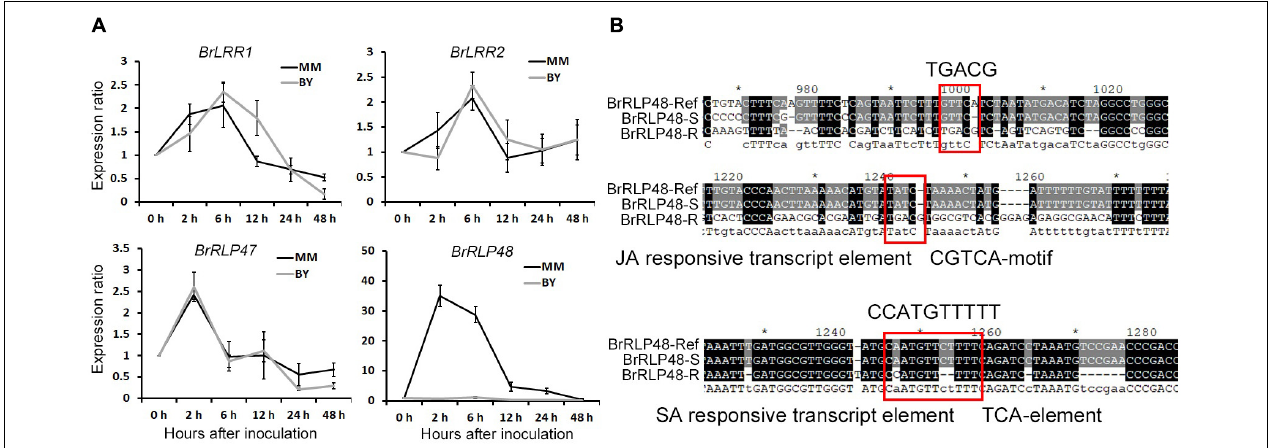
FIGURE 4 | Expression analysis of resistance candidate genes after inoculation and promoter analysis of BrRLP48 between BY and MM. (A) Expression analysis of BrLRR1 , BrLRR2 , BrRLP47 , and BrRLP48 after inoculation. Thirty seedlings of BY and MM were used. Ten to fifteen leaves were mixed in a sample. Expression of each gene at 0 h after inoculation was defined as 1.0. Values represent means ± SD ( n = 3) from three technical replicates. (B) Predicted regulatory elements in the promoter of BrRLP48 in MM. The sequences of MM in red rectangles are indicated above. “-R” and “-S” denote MM and BY, respectively.